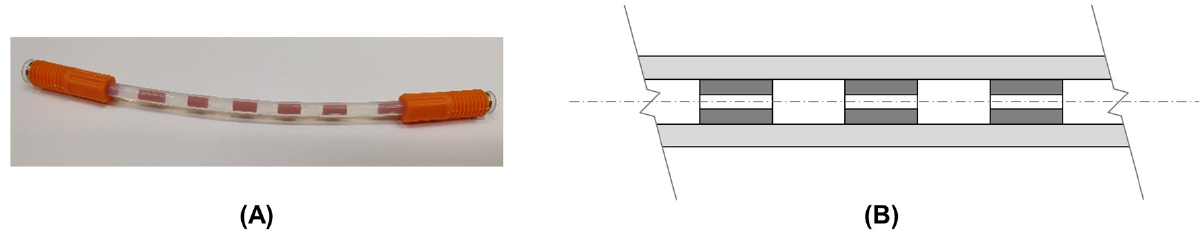
Figure 2. One unit of the alternating diameter reactor. Photograph of the assembled reactor ( A ) and schematic cross-section view ( B ), not to scale, end fittings are omitted). For dimensions and assembly instructions, see Supplementary